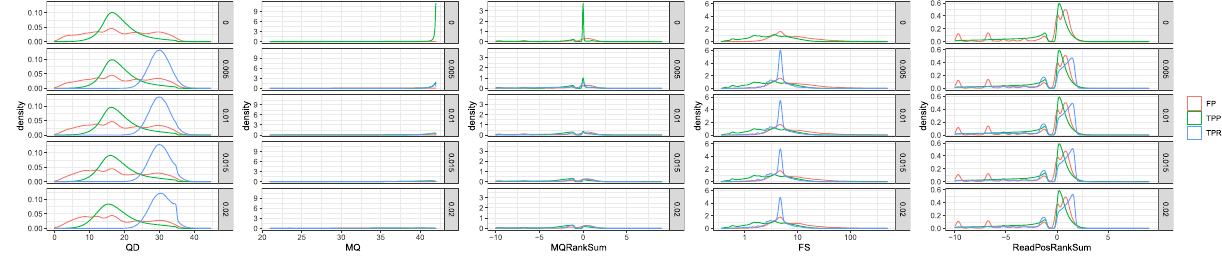
Figure 3. Variant scores calculated by GATK. The density plots of five scores of true positive and false positive SNVs. TPP, TPR, and FP are true positives from P, true positives from D, and false positives, respectively. Please note that the heights do not show relative abundance among TPP, TPR, and FP.